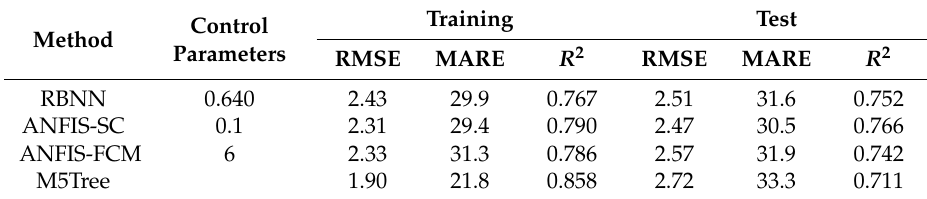
Table 5. Rule base of the optimal ANFIS-SC in modeling strain.